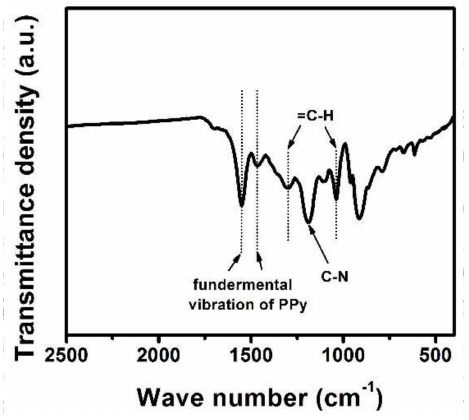
Figure 3. FTIR spectrum of